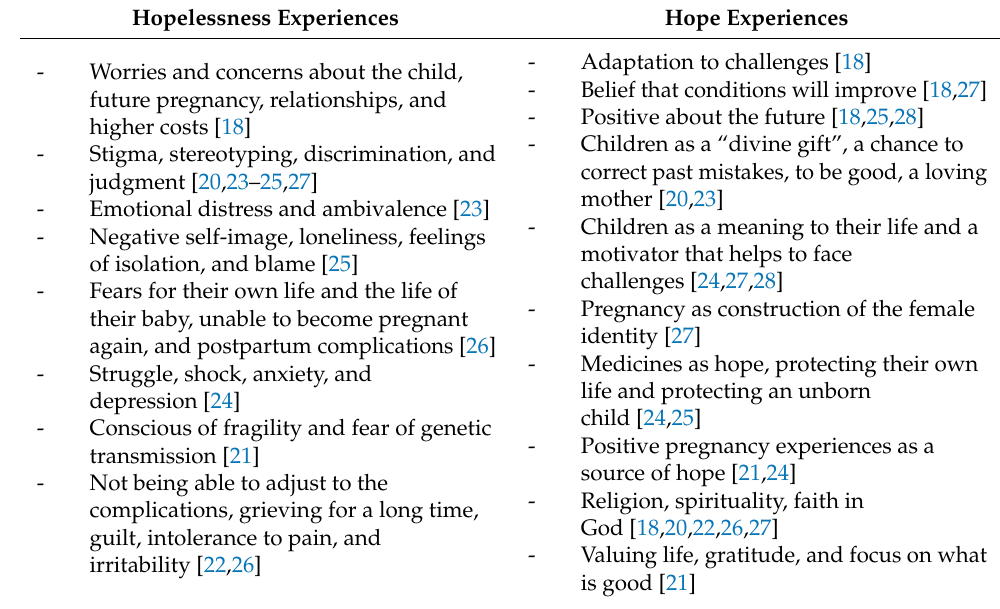
Table 1. Hopelessness and hope experiences in women with medical conditions. Hopelessness Experiences